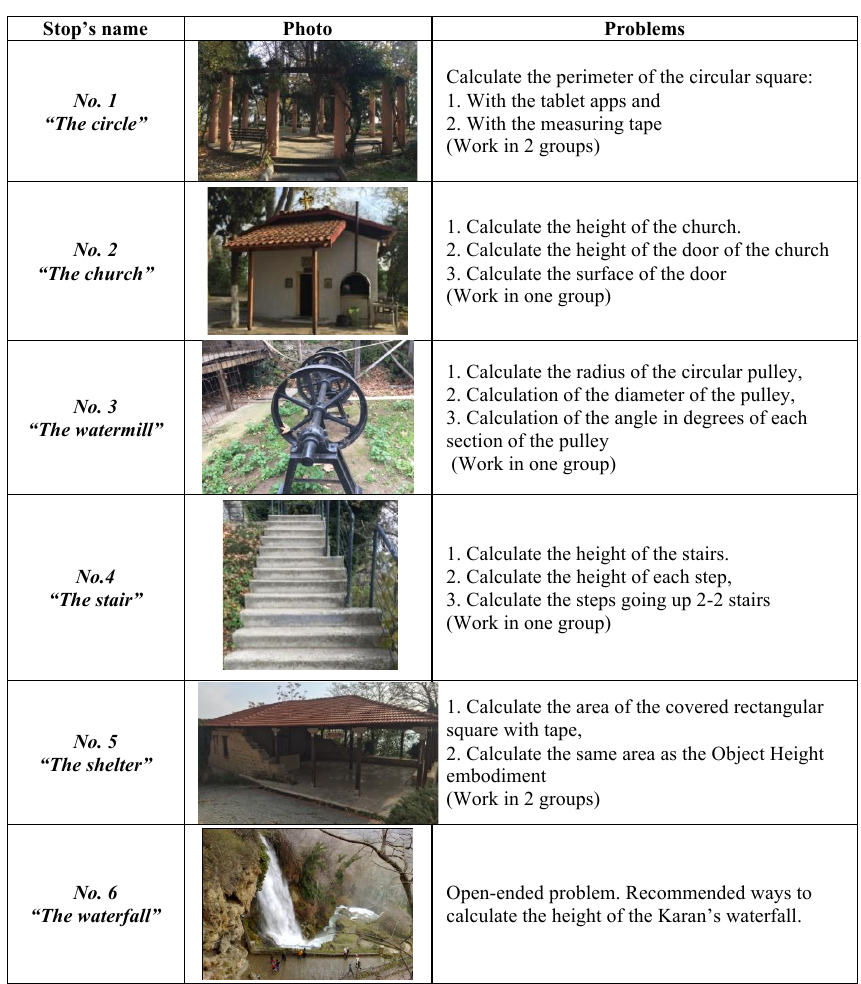
Table 1. The math trail’s stops and